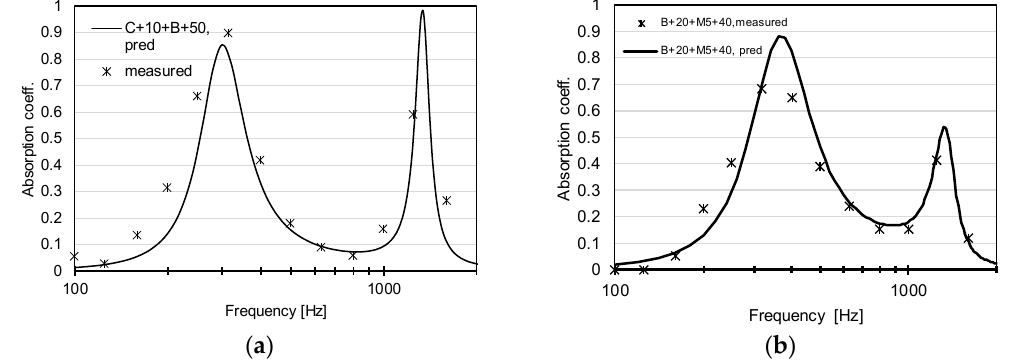
Figure 6. Comparison of the predicted and measured sound absorption coefficients for: ( a ) double-panel structure: perforated panel C followed by a 10 mm cavity combined with panel B followed by a 50 mm cavity, ( b ) perforated panel B followed by a 20 mm cavity combined with M5 followed by a 40 mm cavity.